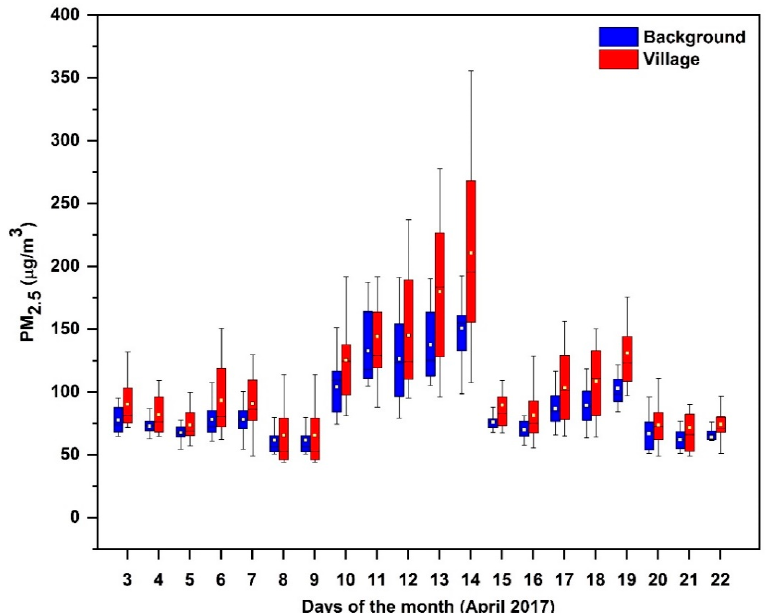
Figure 5. Box plot showing daily variation of PM 2.5 ( µ g / m 3 ) concentration for background (blue shade) and village (red shade). The upper and lower edge of each box represent the 75th and 25th percentiles, respectively; the top and bottom of the whisker represent the 90th and 10th percentiles, respectively. The square box mark within each box represents the average PM 2.5 concentration and the horizontal mid-line in each box represents the median.